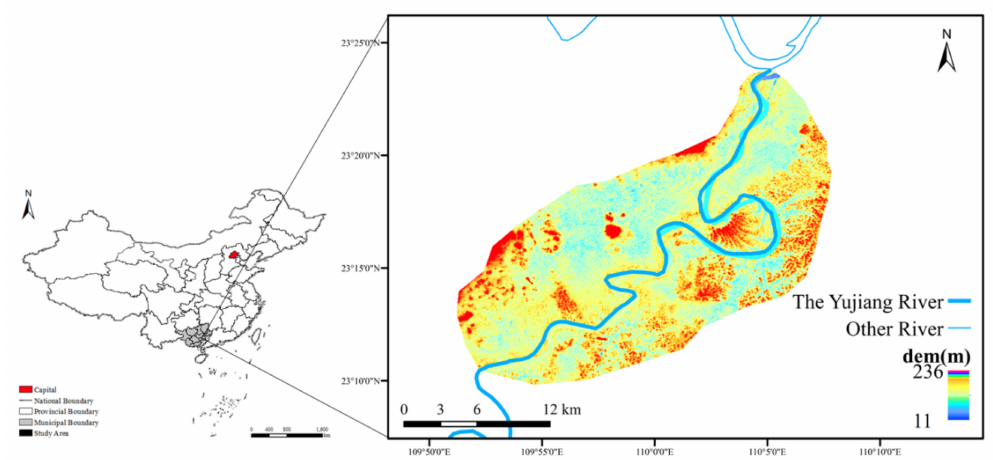
Figure 2. Overview of the cassava planting area of the Yujiang River Basin.